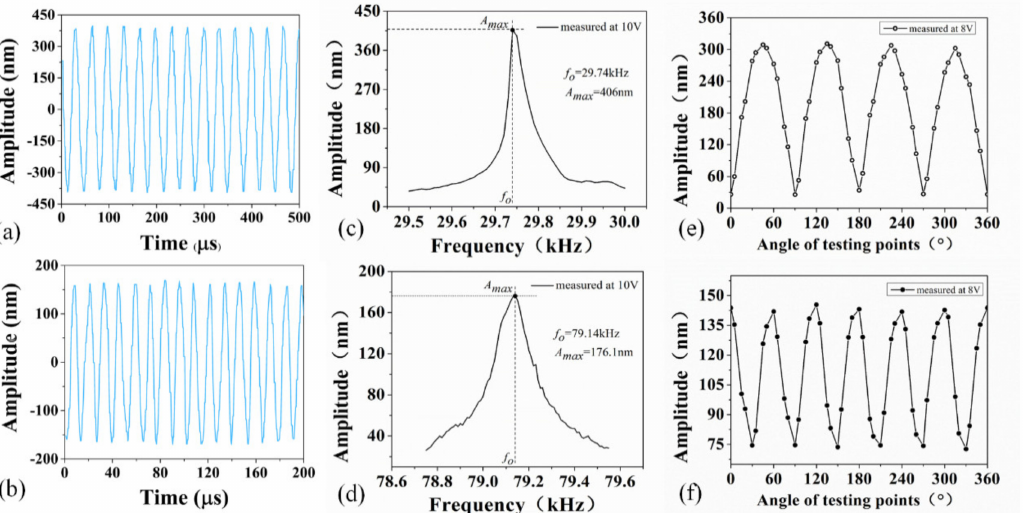
Figure 7. ( a , b ) Steady-state amplitudes curves of the B02 and B03 modes; ( c , d ) Amplitude-frequency curves of the B02 and B03 modes; ( e , f ) Amplitude distribution of micro piezoelectric vibrator in circumferential direction of the B02 and B03